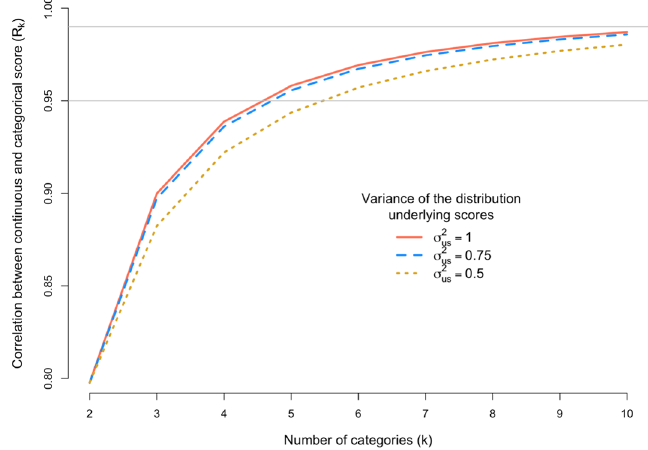
Figure4.Lossof informationinducedbyscoringtoofewgrants inextremecategories. Thex-axisisthenumber of discrete categorical scores (k) and the y-axis shows the correlation (R k ) between the observed categorical score (Y) and the underlying continuous score (u). The correlation R k is calculated under three scenarios defined by the variance ( σ 2 s ) of the distribution of underlying scores. The grey horizontal line denotes a correlation of 0.95 or